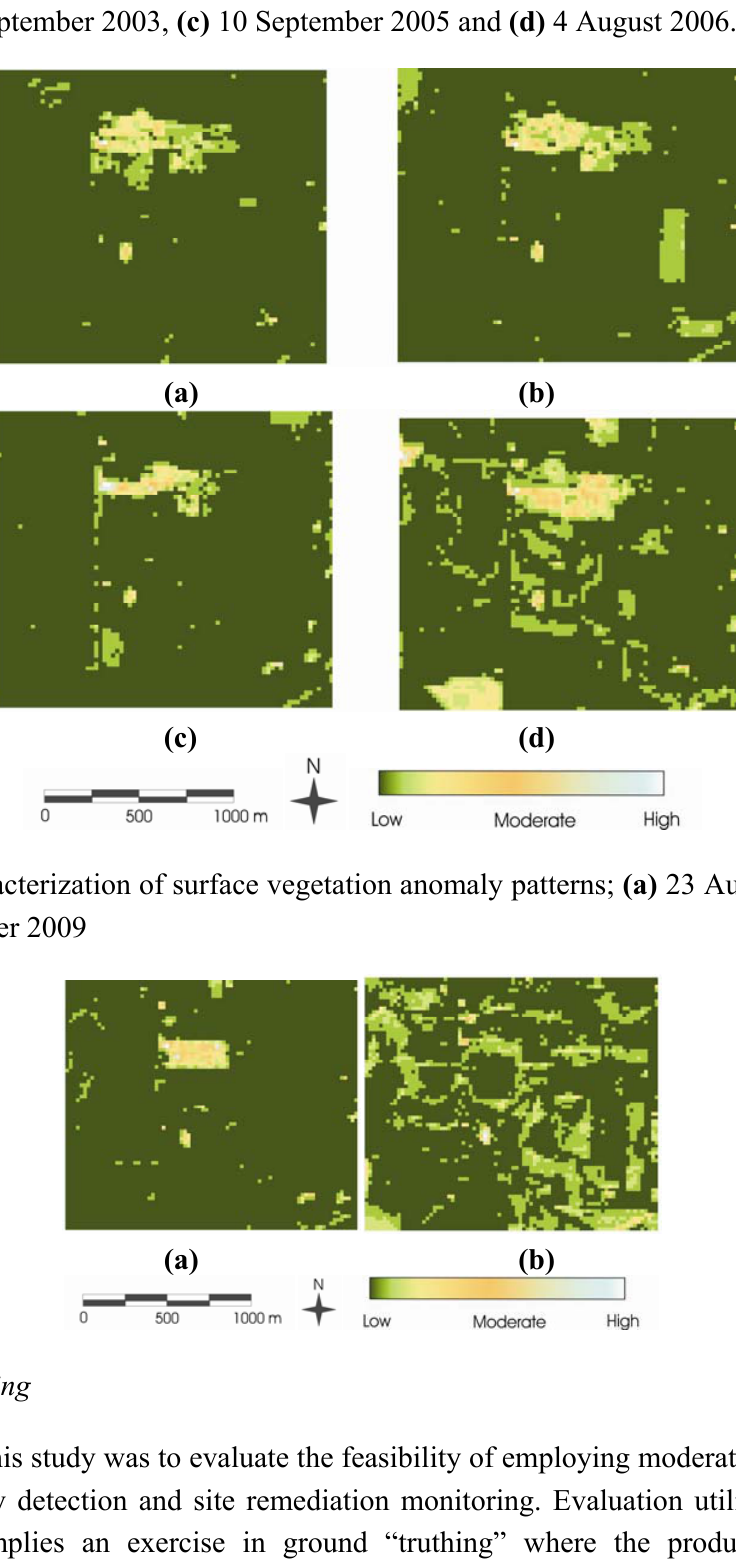
Figure 7. Characterization of surface vegetation anomaly patterns continued: (a) 6 August